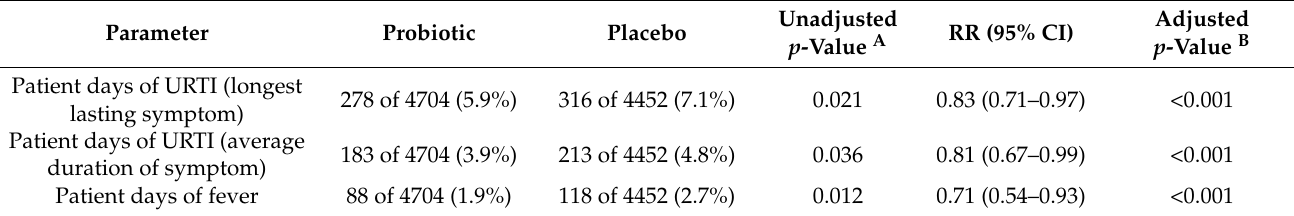
Table 2. Proportion of patient days for longest lasting symptom, average duration and fever from 109 adult subjects randomly assigned to 12 weeks of double-blind treatment with either 10 9 CFU/day L. plantarum DR7 ( n = 56) or placebo ( n =